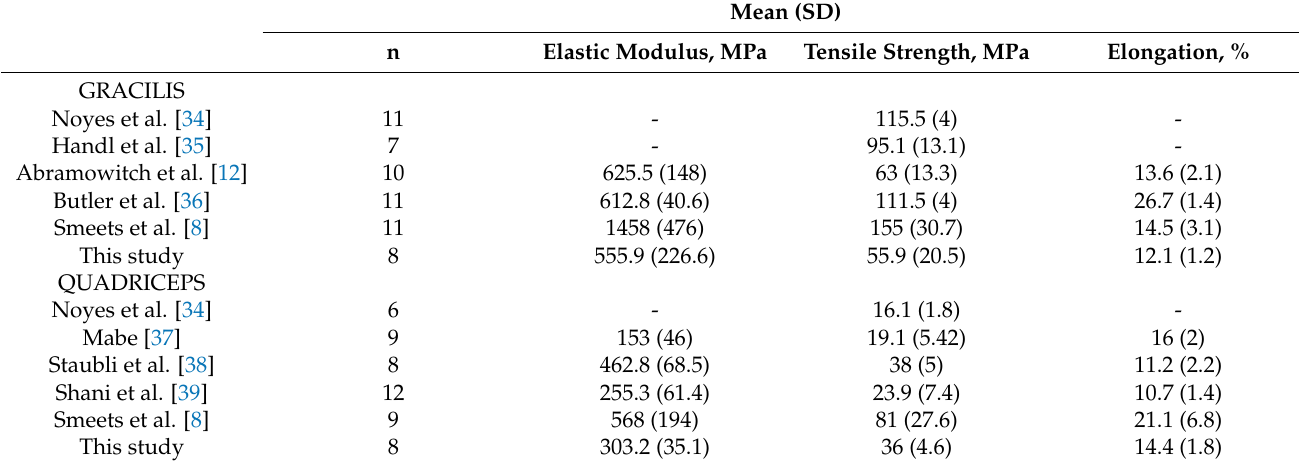
Table 5. Comparison of available data from other studies with this study [24] (reprinted from Wertheimer, V.; Grgi´c, I.; Zeli´c, Z.; Ivandi´c, Ž.; Koprivˇci´c, I.; Zeleni´c, M.; Karakaši´c, M. (2021)). Mean (SD) n Elastic Modulus, MPa Tensile Strength, MPa Elongation,